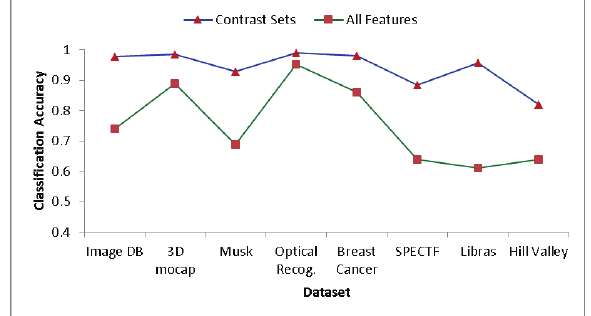
Fig. 5. Comparison of the overall classification accuracy of the discovered contrast sets with that of the whole feature vector of five different datasets.